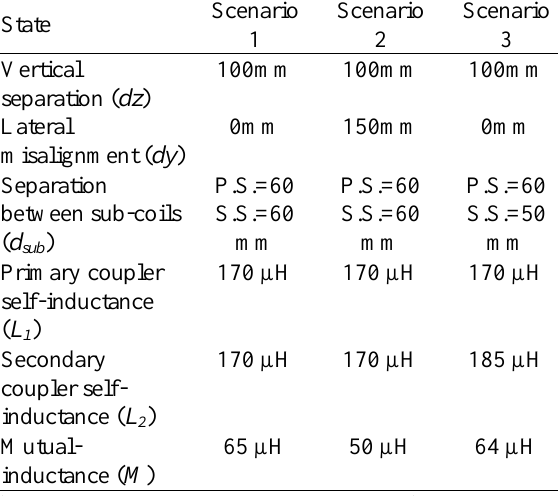
Table 2: Details of experimental scenarios